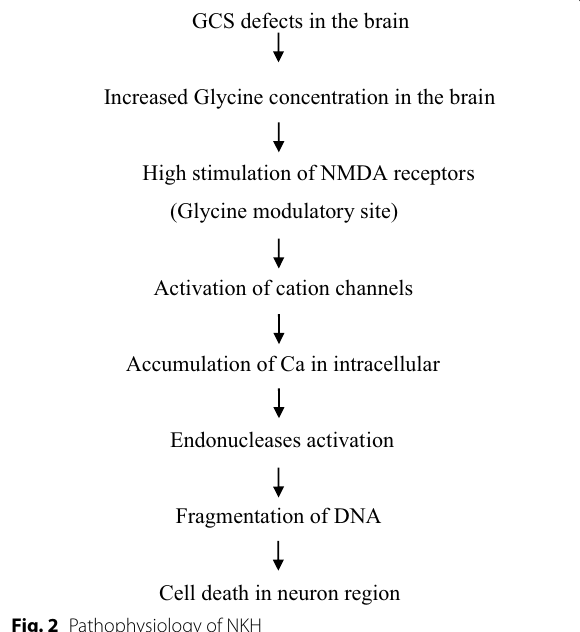
Fig. 2 Pathophysiology of